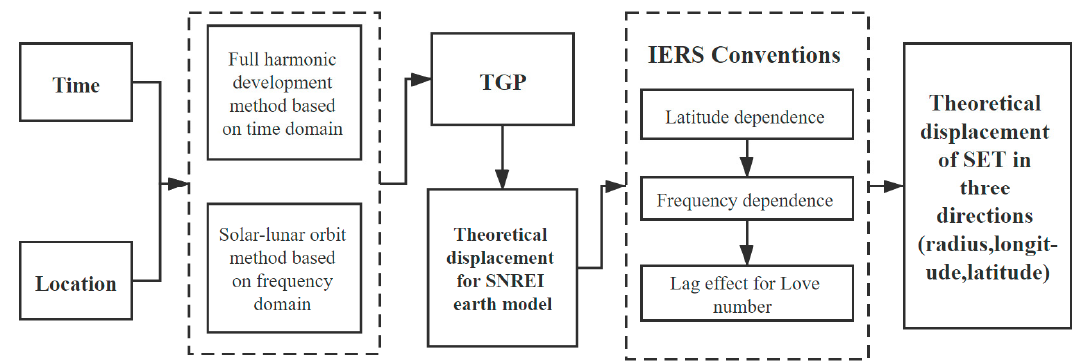
Figure 1. Flowchart of theoretical tidal displacement model. After inputting the time and location information, the tide-generating potential (TGP) can be calculated by using the time domain or frequency domain algorithm, and it is then converted into displacement information in a spherically stratified and non-rotating earth with perfectly elastic and isotropic structural relation (SNREI Earth). The theoretical values of the tidal displacement with millimeter accuracy can be obtained by precise tidal correction based on the IERS Conventions.